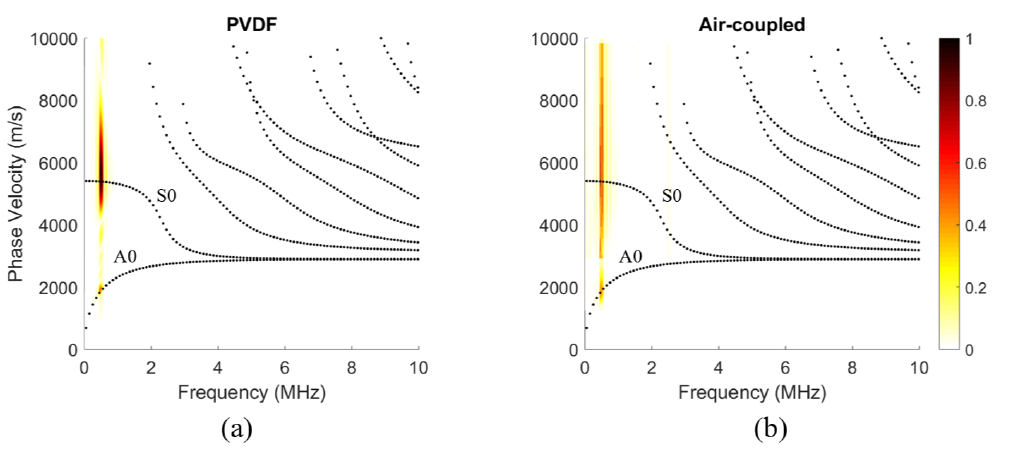
Figure 9. Lamb wave dispersion curves with: ( a ) a normalized phase velocity–frequency spectrum that was measured using the PVDF transducer; and ( b ) s re-scaled, then normalized phase velocity–frequency spectrum measured using the air-coupled transducer. Numerically calculated Lamb wave dispersion curves (black dots) added for reference.